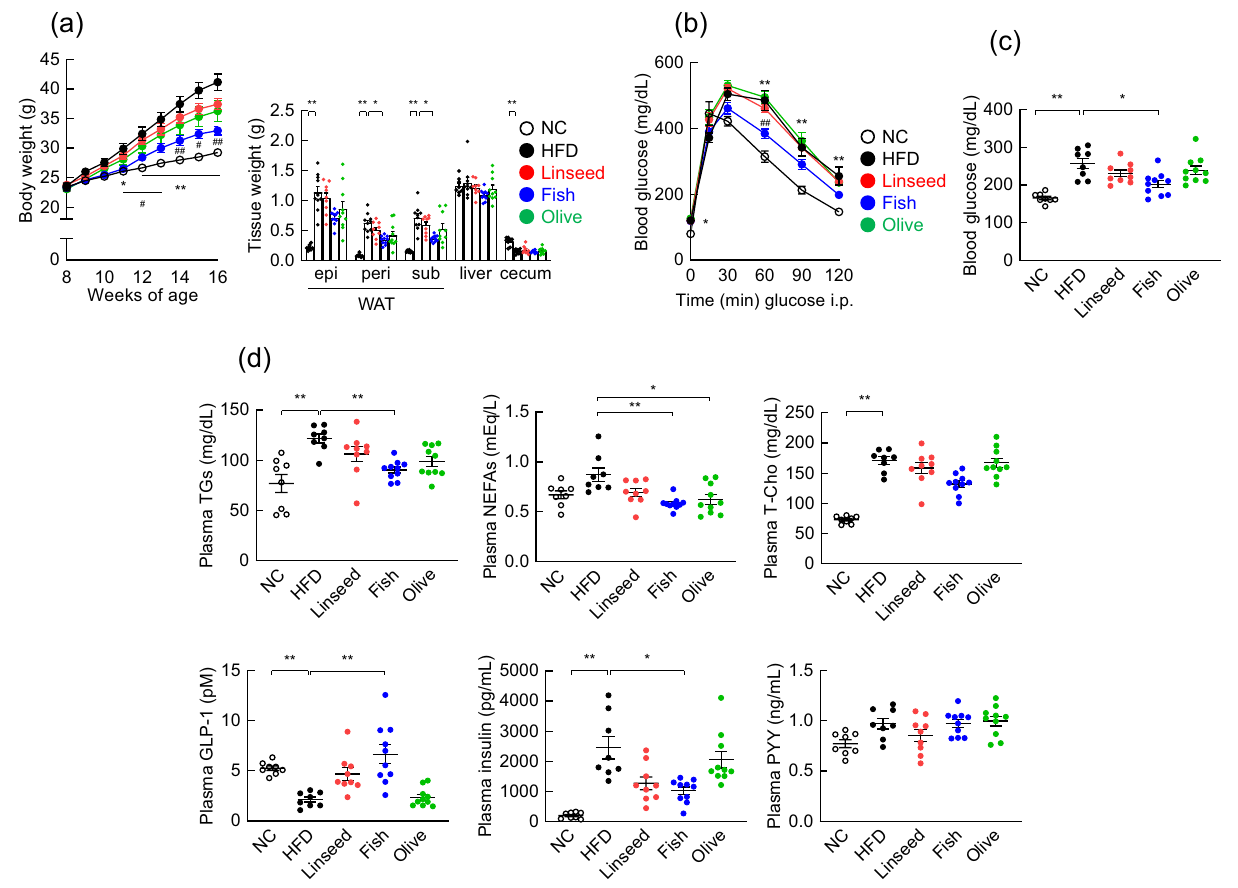
Figure 2. Polyunsaturated fatty acid-containing dietary lipids prevent high fat diet-induced obesity. ( a–d ) C57BL/6J male mice were fed either normal chow (NC), a high fat diet (HFD), or a modified HFD diet [Soybean oil in HFD was replaced with either linseed oil (Linseed), fish oil (Fish), or olive oil (Olive)] for 8 weeks. ( a ) Changes in body and tissue weights. epi epididymal, peri perirenal, sub subcutaneous, WAT white adipose tissue. ** P < 0.01; * P < 0.05, vs, NC. ## P < 0.01; # P < 0.05, vs, HFD (Dunn’s test for 8, 15, and 16 weeks of age, and tissue weight and Tukey–Kramer test for 9–14 weeks of age). ( b ) ipGTT was evaluated at 15 weeks of age. ** P < 0.01; * P < 0.05, vs, NC. ## P < 0.01, vs, HFD (Dunn’s test for 0, 30, 90, and 120 min and Tukey–Kramer test for 15 and 60 min). ( c,d ) After 5 h fasting, blood glucose, plasma triglycerides, non-esterified fatty acids, total cholesterol, GLP-1, insulin, and PYY levels were measured at the end of the experimental period (n = 7–10 mice for each group). ** P < 0.01; * P < 0.05 (Dunn’s test for blood glucose, plasma triglycerides, NEFAs, total cholesterol, GLP-1, and insulin and Tukey–Kramer test for PYY). Results are presented as means ± standard